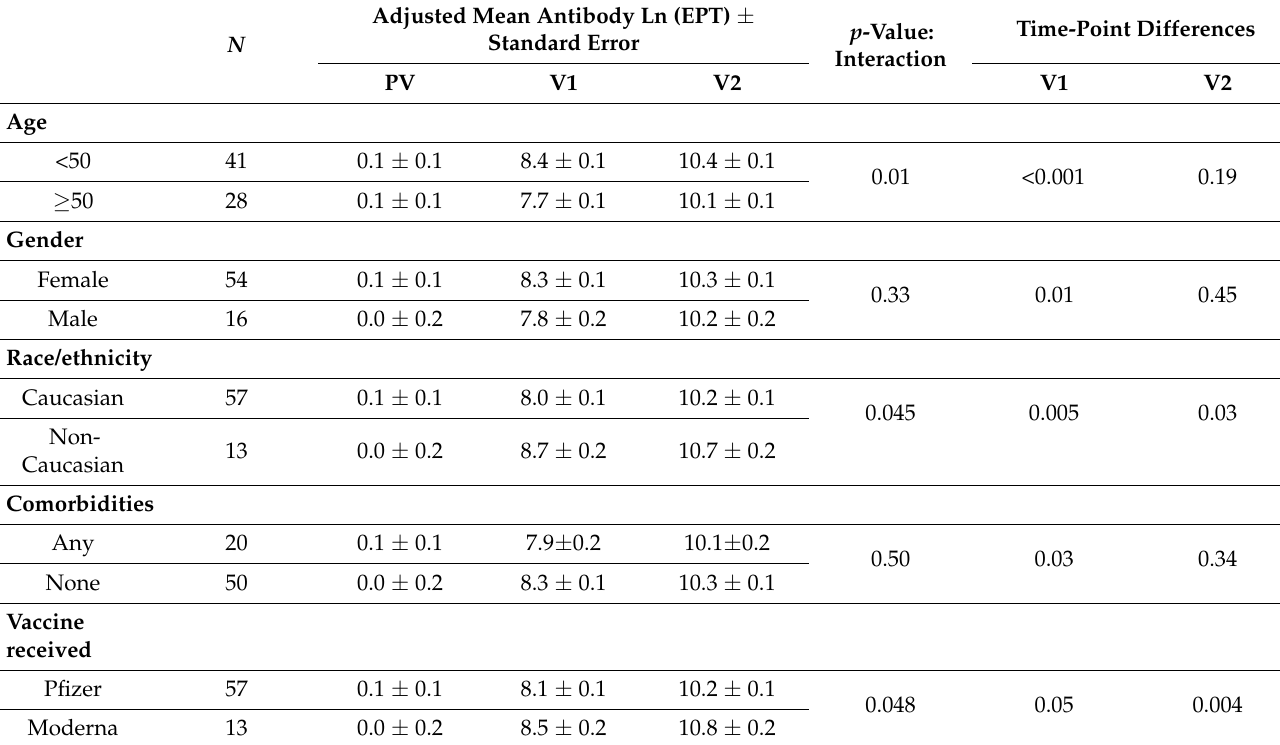
Table 2. Characteristics associated with the antibody response in the CN